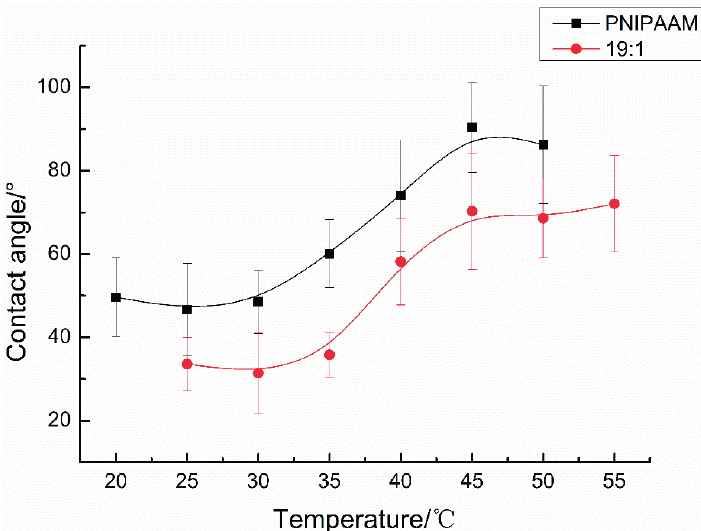
Figure 4. Contact angle measurements of the polymer films.